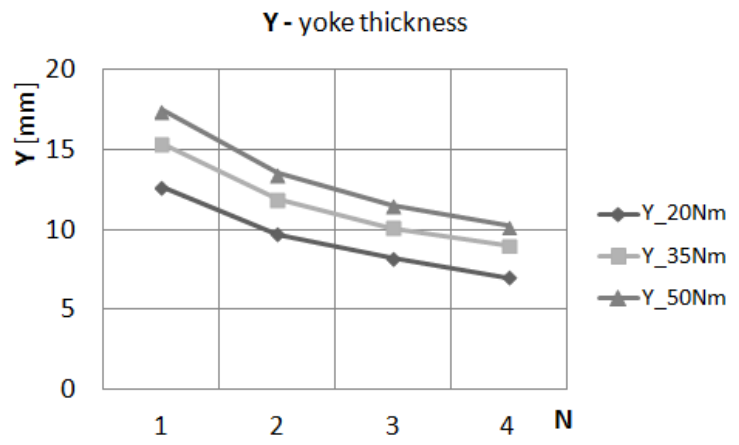
Figure 18. Yoke thickness vs. number of discs N for the clutch T c = 20